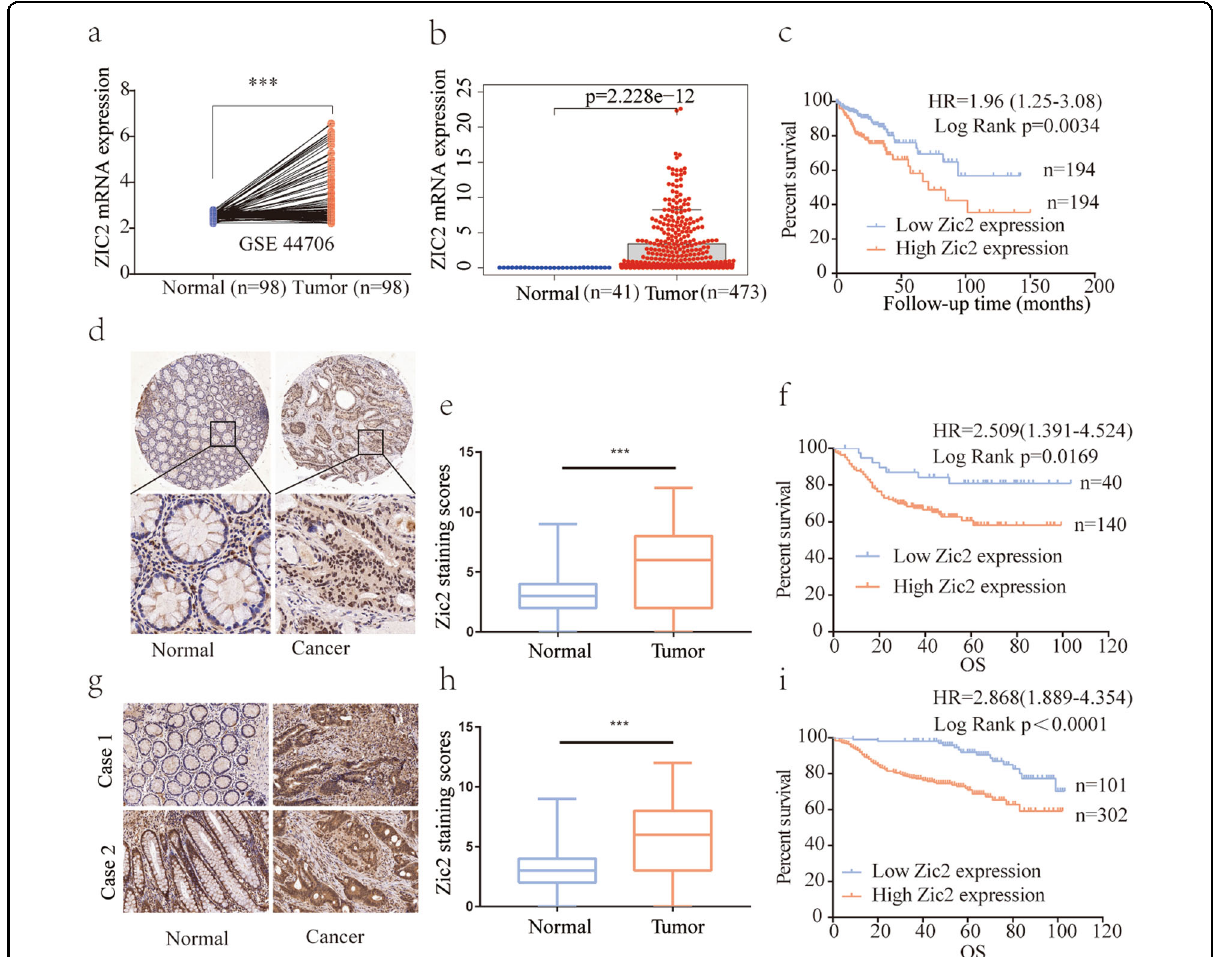
Fig. 1 The expression of Zic2 in colon cancer tissue samples and normal tissue samples. a Zic2 mRNA expression of 98 colon cancer tissue samples and paired NC tissue samples in GSE 44706 mRNA microarray. b Zic2 transcription expression of 473 colon cancer tissue samples and 41 NC tissue samples in TCGA database. c Data in TCGA database showed the overall survival of the two groups of patients with high ( n = 194, red line) or low ( n = 194, blue line) Zic2 expression in colon cancer tissues. d , g Representative images of the IHC staining of Zic2 in two independent cohorts (Cohort I ( d ), N = 180; Cohort II ( g ), N = 403). e, h The staining scores of the Zic2 expression in two independent cohorts. f , i Kaplan – Meier representation of the overall survival between the two groups of patients with high (red line) and low (blue line) Zic2 expression in two independent cohorts. All data are the mean ± SD of three independent experiments. *** P <